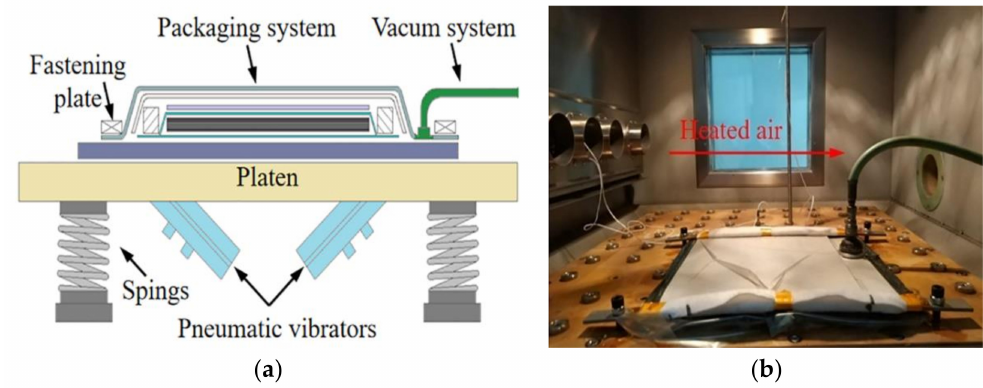
Figure 1. Tooling and preparation for the RVAVP, ( a ) schematic illustration of the experimental-set up configuration, ( b ) a picture of the temperature